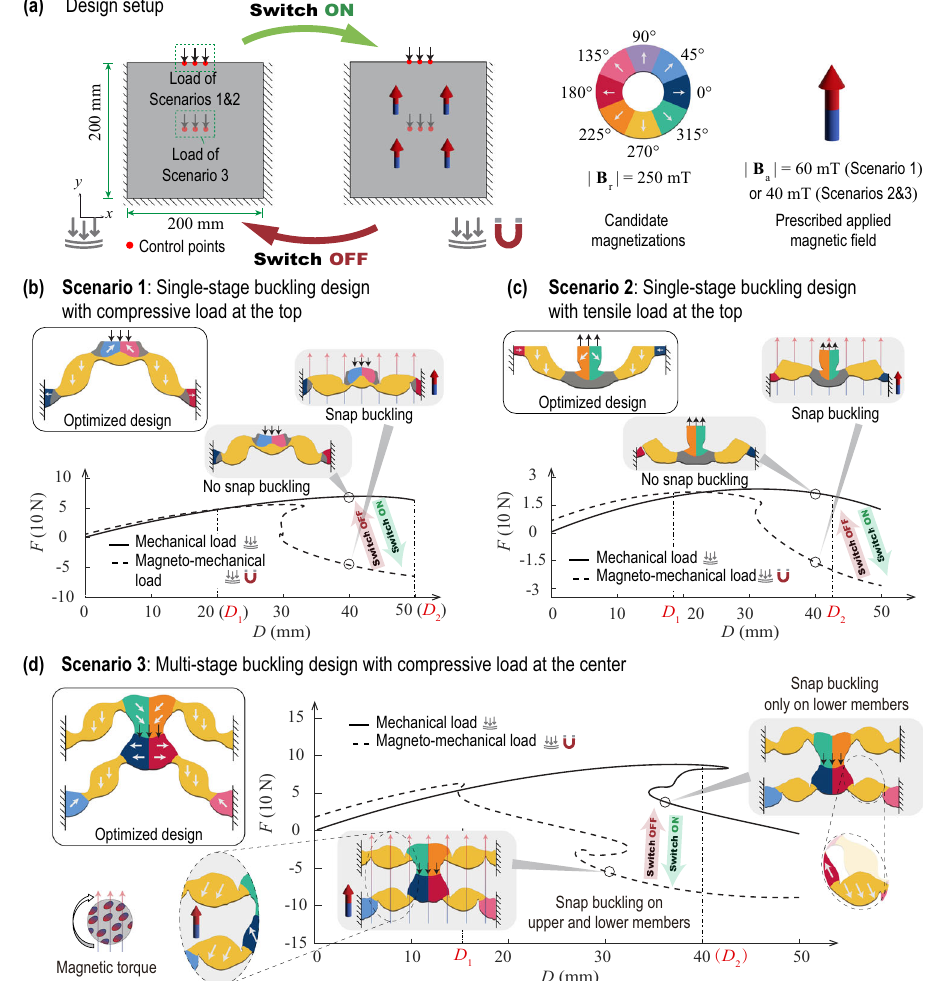
Fig. 3 Magneto-controllable buckling-induced metastructures with reprogrammable behaviors. a Design setup. Metastructures with switchable buckling behaviors enabled by magnetic stimuli under b compressive load; and c tensile load. d Metastructure with switchable multi-stage buckling behaviors under compressive load. Note: the deformed con fi gurations at the circled locations on the FD curves demonstrate the ensured snap buckling through ‘ switching on ’ the magnetic fi